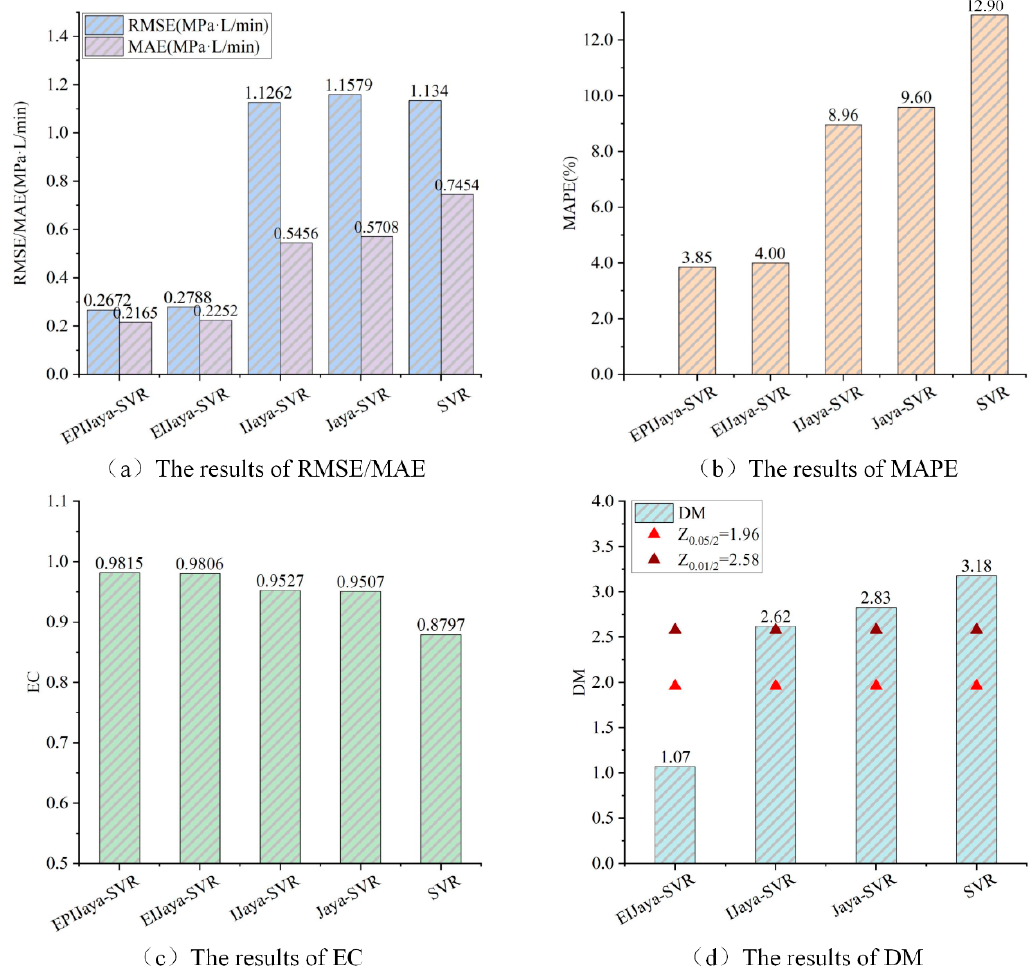
Figure 10. The results of performance indices and DM test of different models.